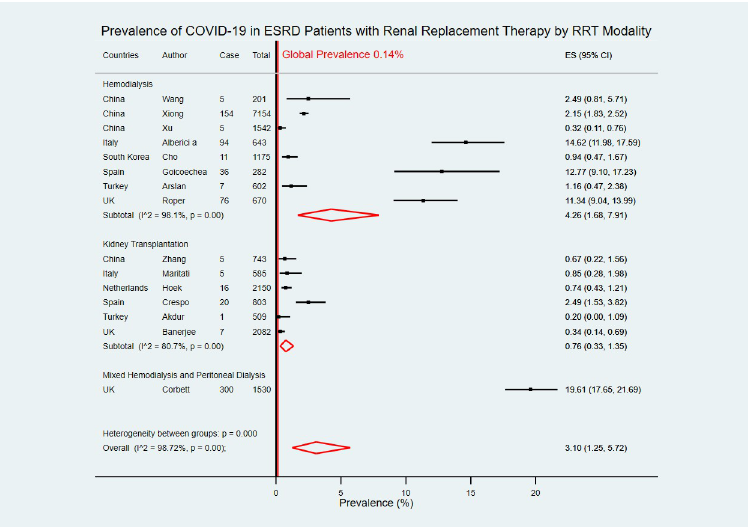
Fig 5. Forest plot of the prevalence of COVID-19 in ESRD patients with RRT by RRT modality. The figure summarizes the number of COVID-19 confirmed cases in ESRD patients with RRT and the total number of ESRD patients with RRT in 15 eligible studies with subgroup analysis by types of RRT modality. The forest plot represents the estimated prevalence of COVID-19 in ESRD patients with RRT for each study (black boxes), with 95% confidence intervals (95% CI; horizontal black lines). The estimated pooled prevalence for each subgroup was presented with a red diamond. The overall estimated pooled prevalence (last red diamond) was 3.10% (95% CI 1.25–5.72). The global average prevalence (vertical red line) was 0.14%. The meta-analysis used a random-effects model with the exact method for confidence interval estimation. ES, effect size. I 2 , test for heterogeneity.